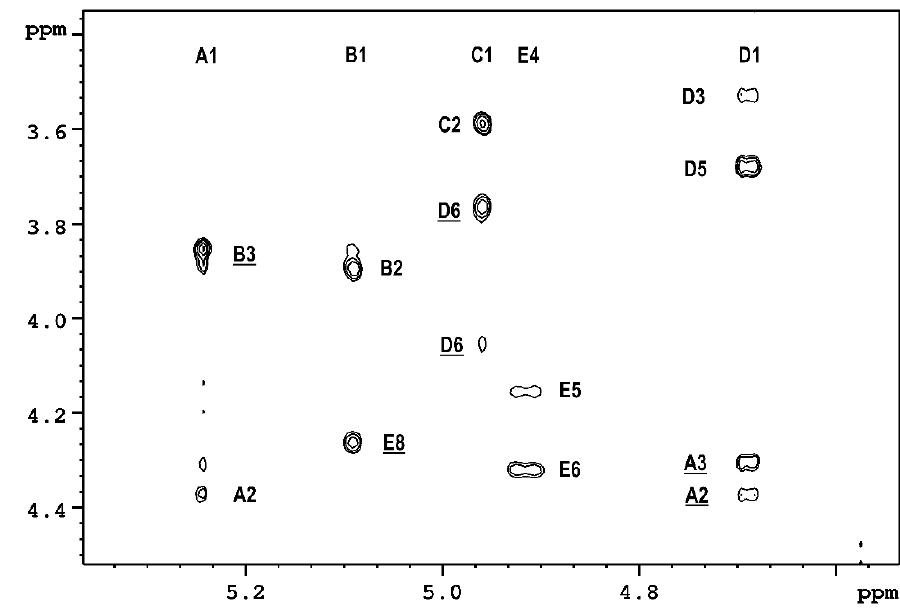
Figure 3. The section of ROESY spectrum of the OPS isolated from P. parmentieri SCC3193. Structural studies carried out for a polysaccharide isolated from the strain